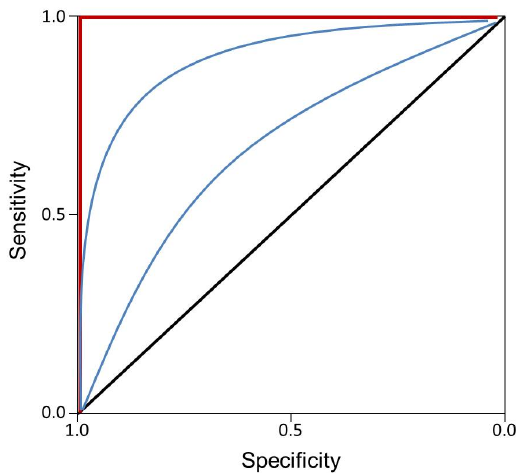
Figure 1. Example receiver operating characteristic (ROC) curve. Black line indicates area under ROC curve (AUC) = 0.5, or random chance. Red line indicates AUC = 1.0, or perfect model. Blue lines indicate varying ROC curves.